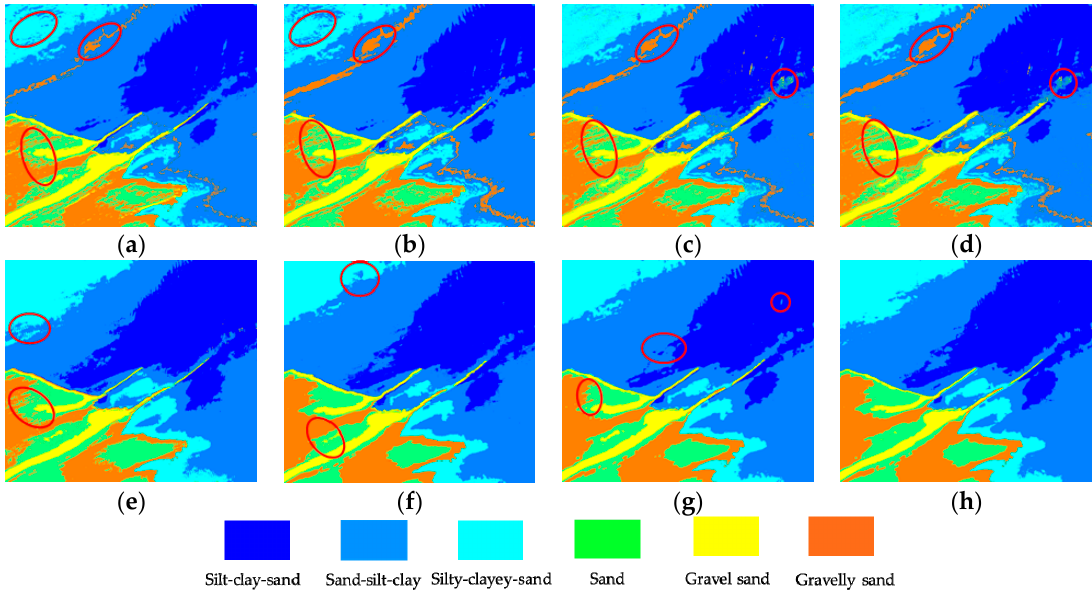
Figure 10. Image classification results of various classifiers on the Z2 area: ( a ) RF, ( b ) SVM, ( c ) GA-SVM, ( d ) PSO-SVM, ( e ) ELM, ( f ) RELM, ( g ) GA-RELM, and ( h ) our MELM. Several areas are marked to show the classification performance.